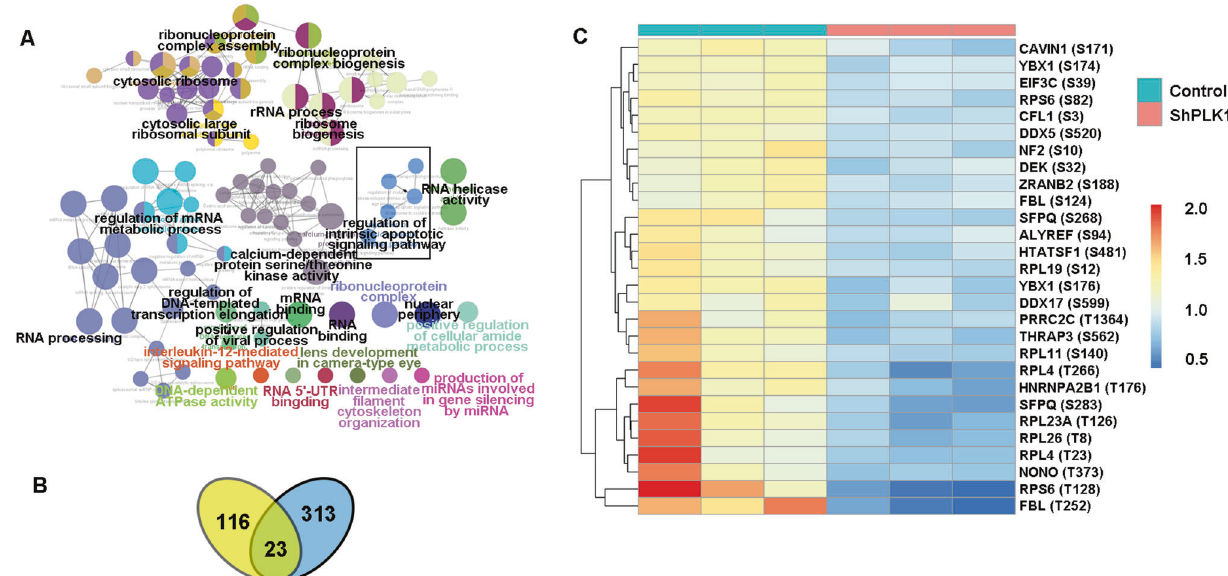
Fig. 4 Identifying the potential direct substrates of PLK1. A GO analysis of proteins with signi fi cantly reduced phosphosites in PLK1 knockdown cells for biological process, molecular function, and KEGG pathway. The visualization of the results was performed with Cytoscape and ClueGOApp. B Venn diagram showing the number of proteins with downregulated phosphosites identi fi ed in response to PLK1 knockdown (yellow), PLK1 interaction candidates identi fi ed in the Co-IP process (blue), and overlapping proteins in the datasets. C The heatmap shows potential substrates of the overlapped